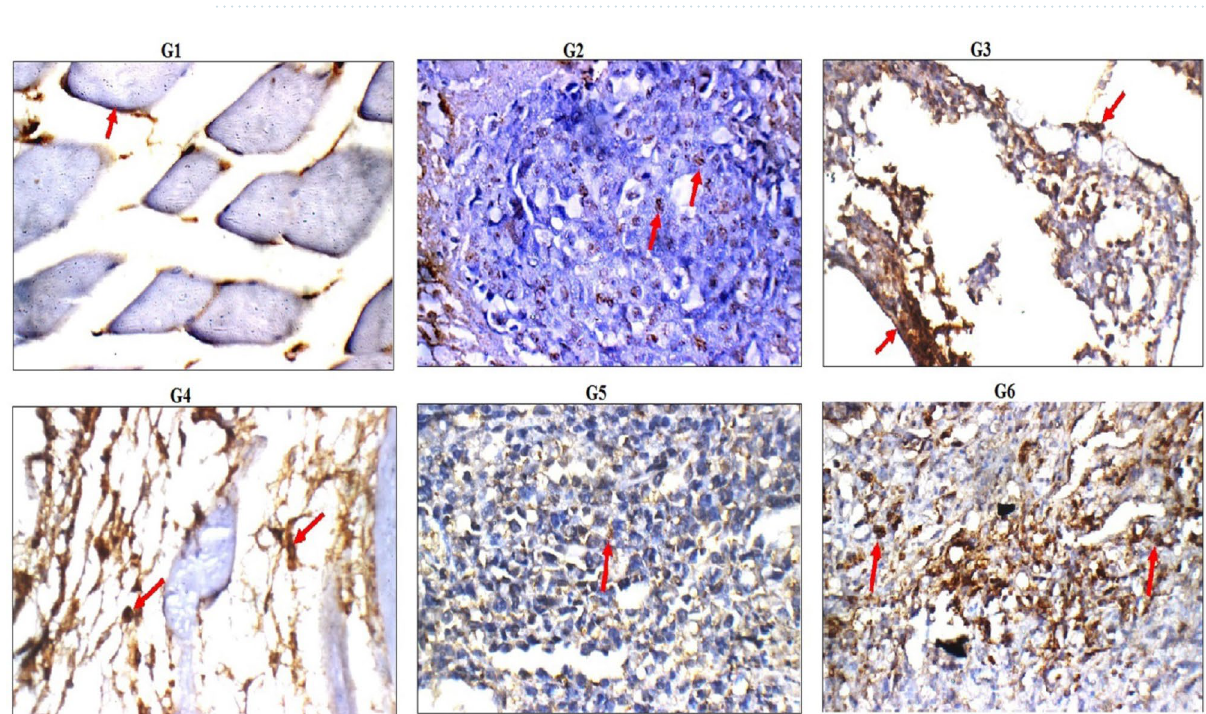
Figure 11. Immuno-histochemical localization of p53 protein (red arrow) in the tumor and muscle tissues of the negative control (G1), tumor control (G2), Doxorubicin treated (G3) and PSO treated (G4–G6) groups (p53 immunostain ×